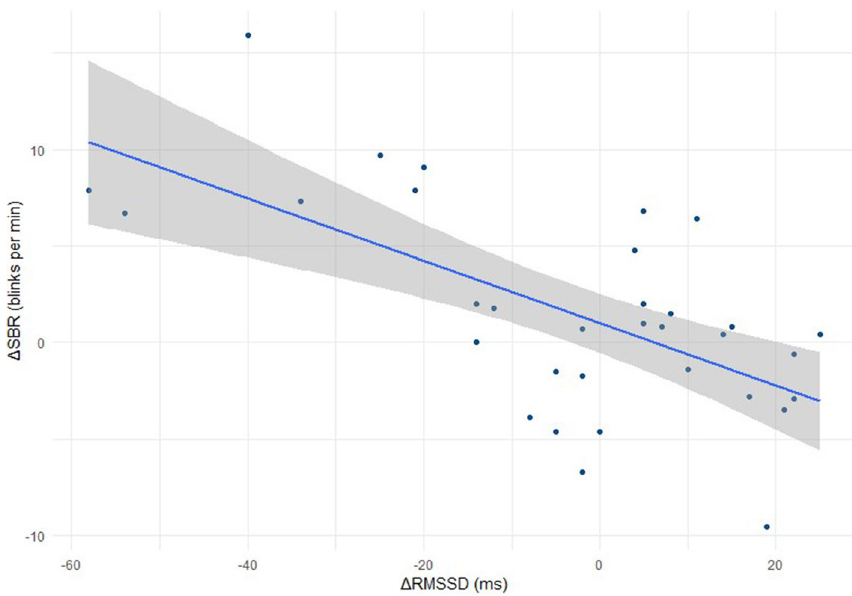
Figure 3. Correlation of SBR with RMSSD. Correlation of change in SBR (B verses CT) against change in RMSSD (B verses CT) for all horses (low and high reactive; n = 33) (r = − 0.63, p <